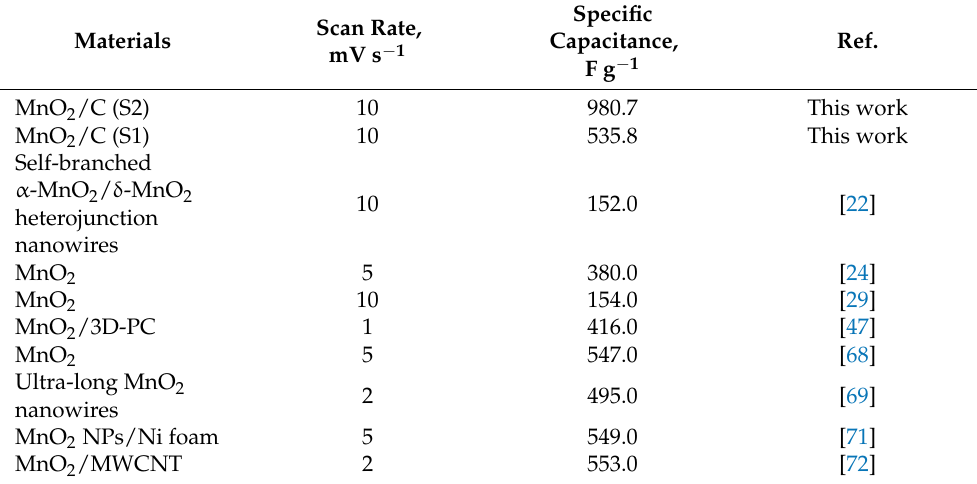
Table 1. Comparisons of specific capacitance for various MnO 2 -based electrode materials.